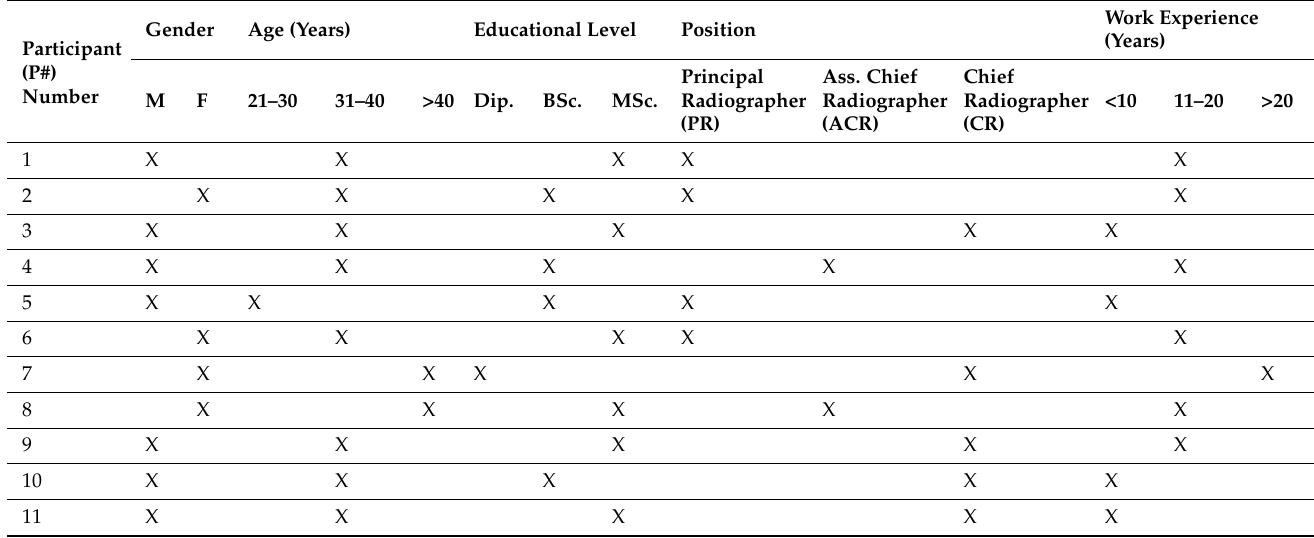
Table 1. Demographics of RMs in HMP.